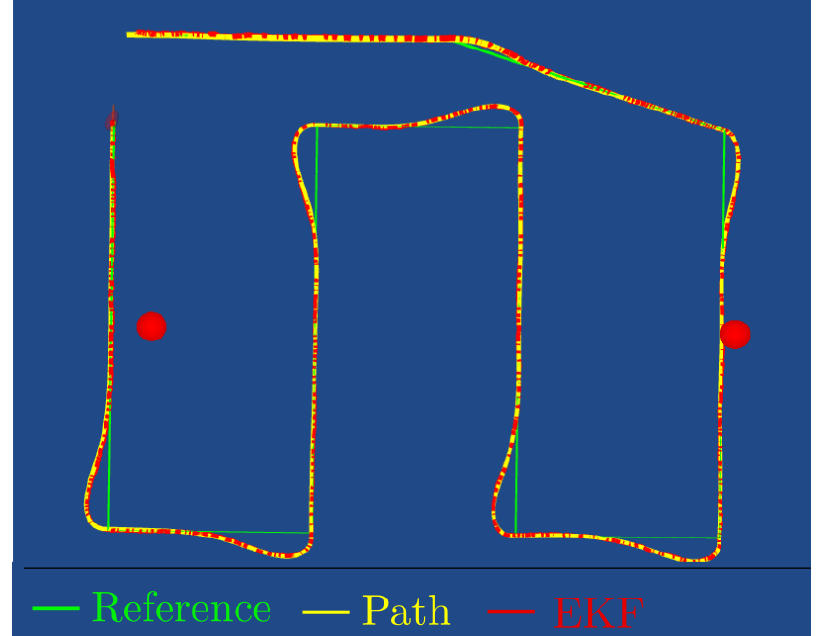
Figure 5. Scenario 1 with extended Kalman